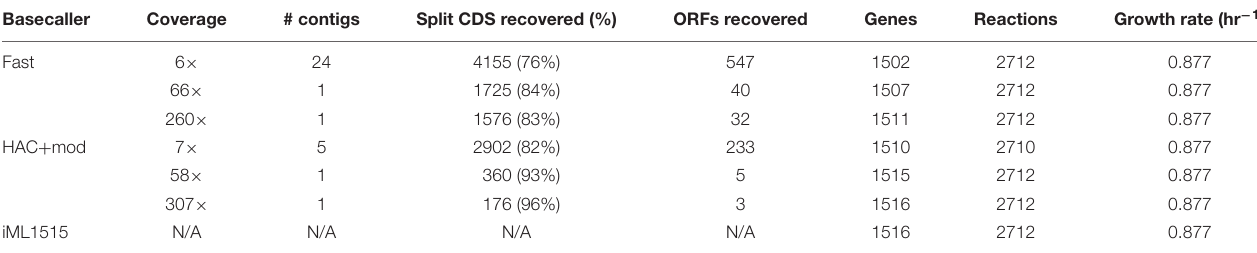
TABLE 3 | Statistics of genome-scale metabolic reconstructions built from the assembly and annotation pipeline. Basecaller